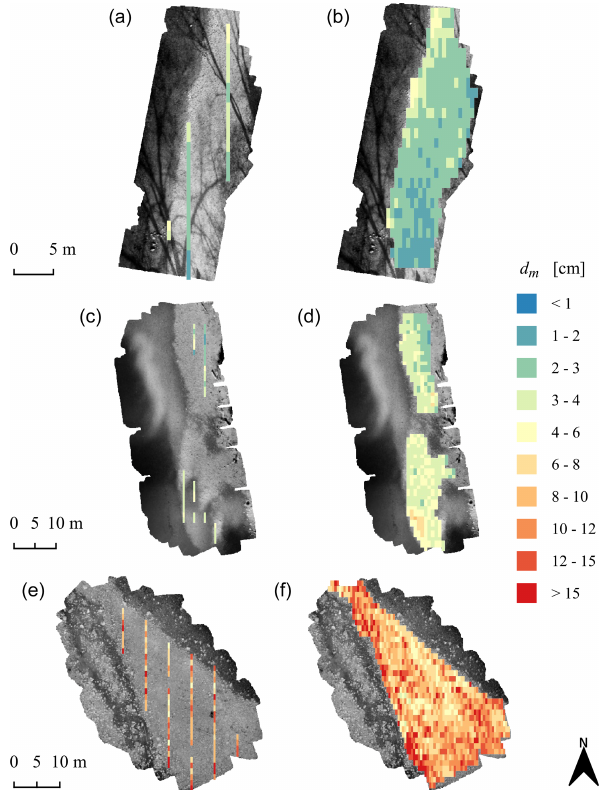
Figure 17. Maps of the characteristic mean diameter d m , manually labeled ground truth, i.e., digital line samples (a, c, e) and GRAINet end-to-end d m predictions (b, d, e) . Gravel bars (top to bottom): Reuss km 012.0 , Aare km 171.0 , and Grosse Entle km 002.1 . The background is a grayscale version of the input UAV